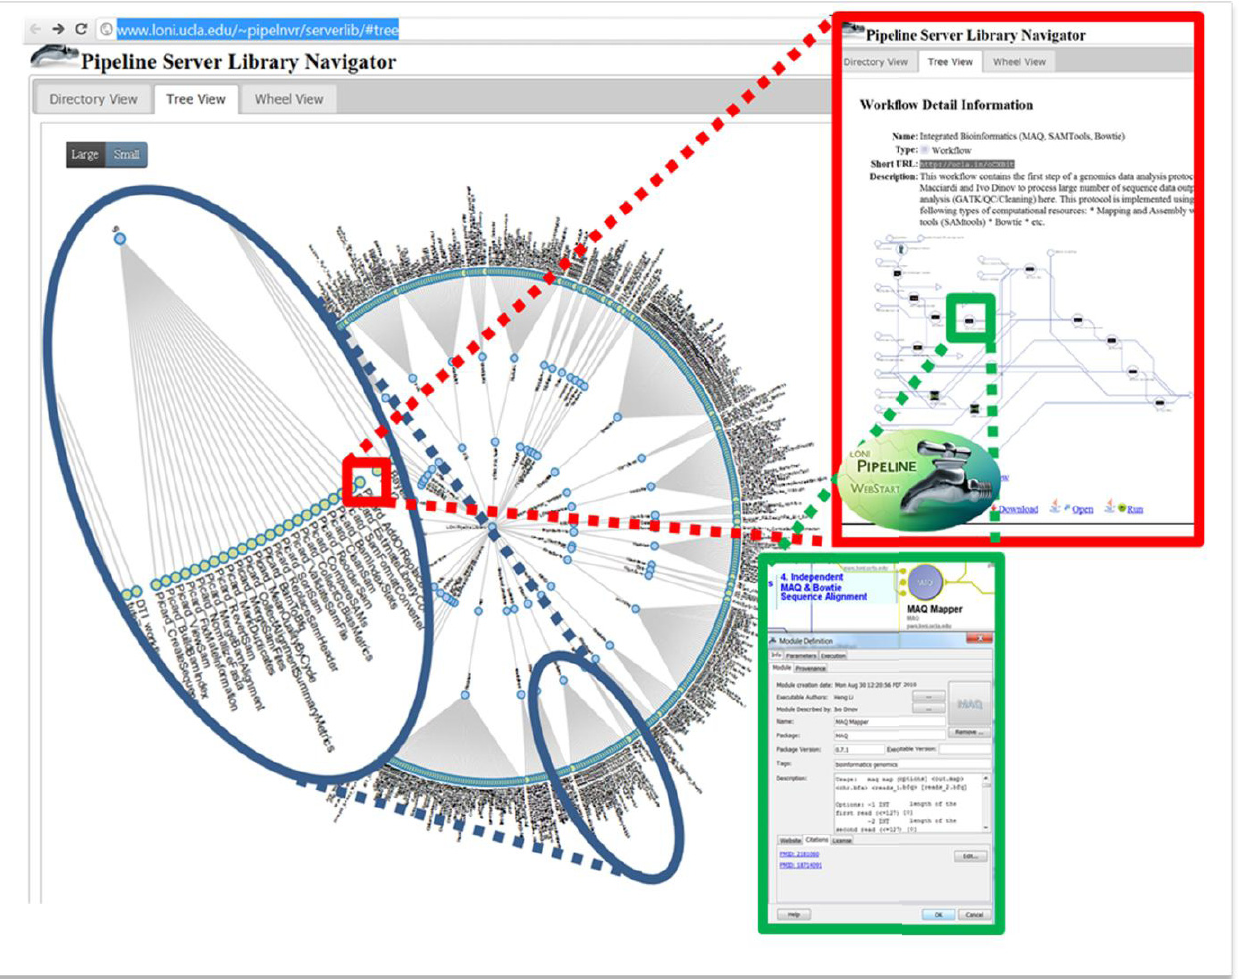
Figure 10. The LONI pipeline computational library Navigator allows the interactive traversal, inspection, downloading and utilization of specific NGS analyses. Nested insert images illustrate the most common steps of search, selection, comparison, modification and execution of available end-to-end computational genomics